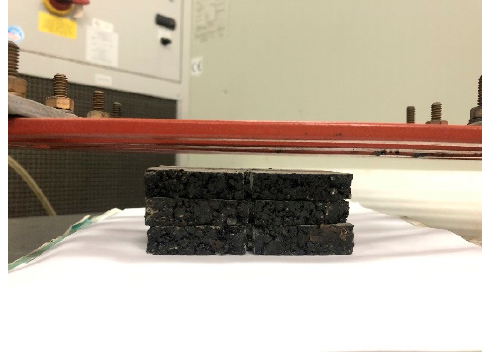
Figure 7. Induction heating of three-layer beams. Table 2. The test summary.